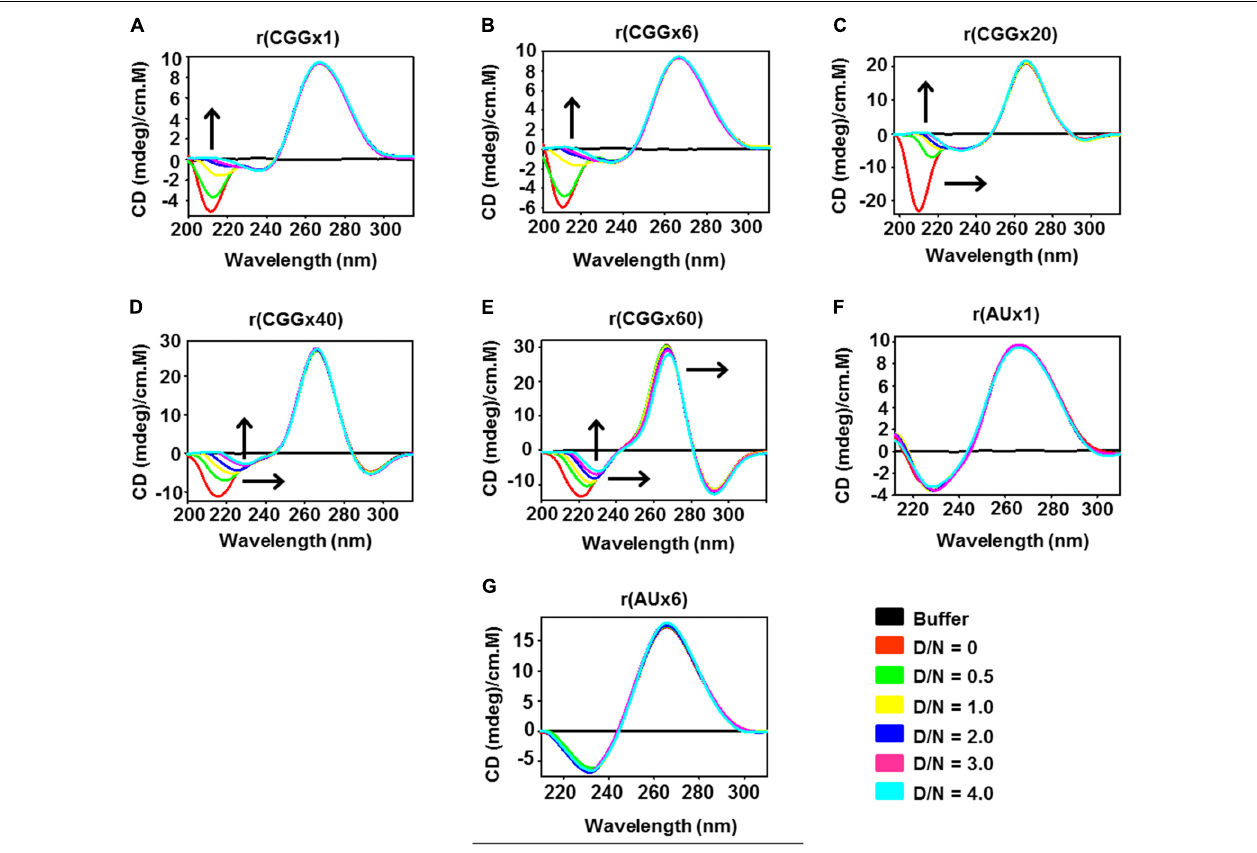
FIGURE 3 | Circular Dichroism spectroscopy study of different CGG RNAs repeats and AU duplex RNA with increasing concentration of Curcumin. Plot (A) r(CGGx1), (B) r(CGGx6), (C) r(CGGx20), (D) r(CGGx40) and (E) r(CGGx60) shows spectral variation with the increasing concentration of Curcumin, whereas no significant changes were observed with (F) r(AUx1), and (G) r(AUx6) duplex RNAs. Arrow heads denotes the shifting of negative and positive peaks upon drug titration. D/N denotes drug by nucleotide ratio. Each spectrum was recorded three times and average changes were